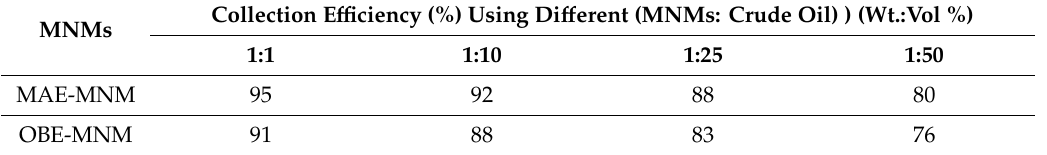
Table 1. Efficiency (%) of synthesized magnetite nanomaterials (MNMs) on the collection of oil spills at different ratios of MNMs to crude oil.